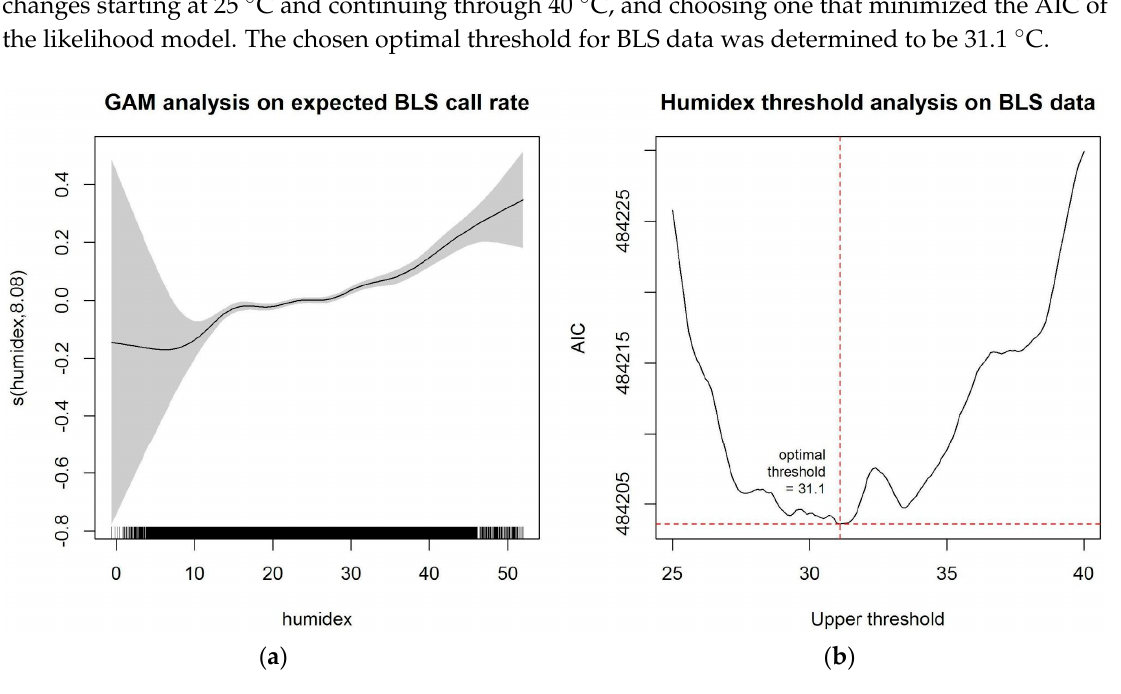
Figure 1. Temporal analysis on extreme heat threshold for BLS data: ( a ) Generalized additive model (GAM) with penalized regression spline of log expected daily BLS call rate and humidex; ( b ) Plot of AIC (Akaike Information Criterion) for the likelihood model when choosing optimal threshold between 25 °C and 40 °C.